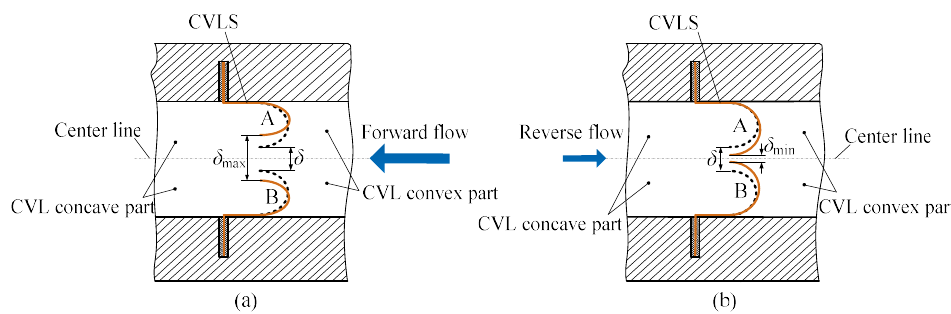
Figure 1. Diagram of working principle of cardiac valves: ( a ) suction stroke and ( b ) exhaust stroke.